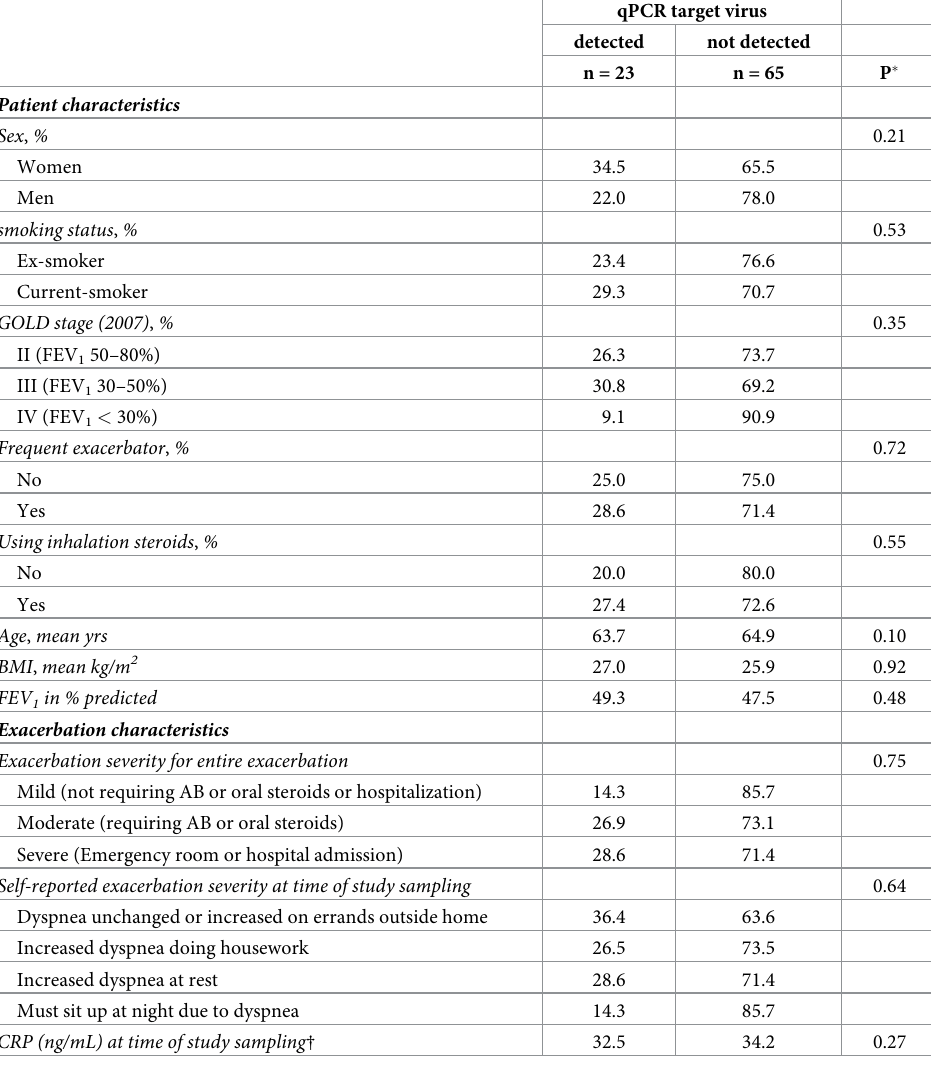
� Pearson’s chi square test for categorical variables and t-test for continuous variables † missing data for 4 (1 virus positive, 3 virus negative) exacerbations